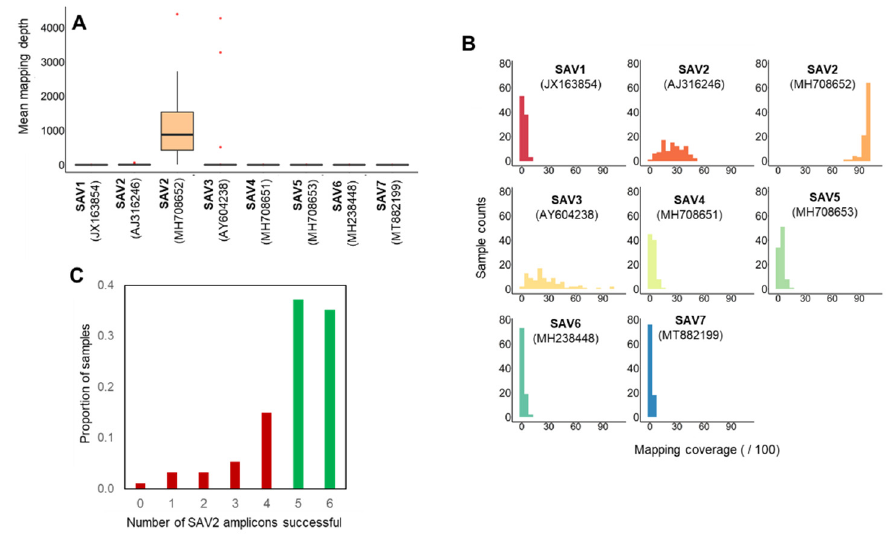
Figure 3. Summary statistics for SAV nanopore sequencing data. ( A ) Boxplot depicting mapping depth across the reference genomes for the seven SAV subtypes (n = 94 samples). Mapping depth represents the number of times the base pairs in the SAV genome are covered by the mapped nanopore reads. ( B ) Frequency histogram depicting the number of samples showing genome-wide coverage against the same reference genomes (bin-widths of 5%). Coverage represents the proportion of base pairs in the reference genome covered by mapped nanopore reads. ( C ). Histogram showing the number of successful amplicons generated (out of 6) as a proportion of n = 94 samples.